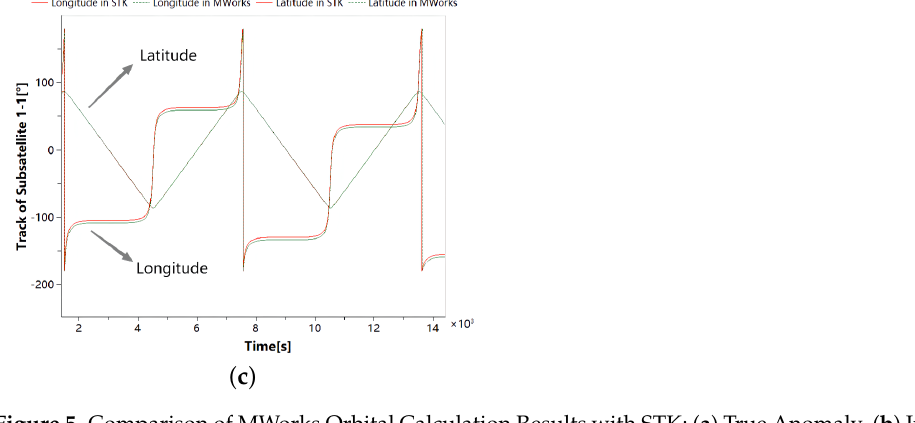
Figure 5. Comparison of MWorks Orbital Calculation Results with STK: ( a ) True Anomaly. ( b ) Inertial Position. ( c ) Subsatellite Point Track.